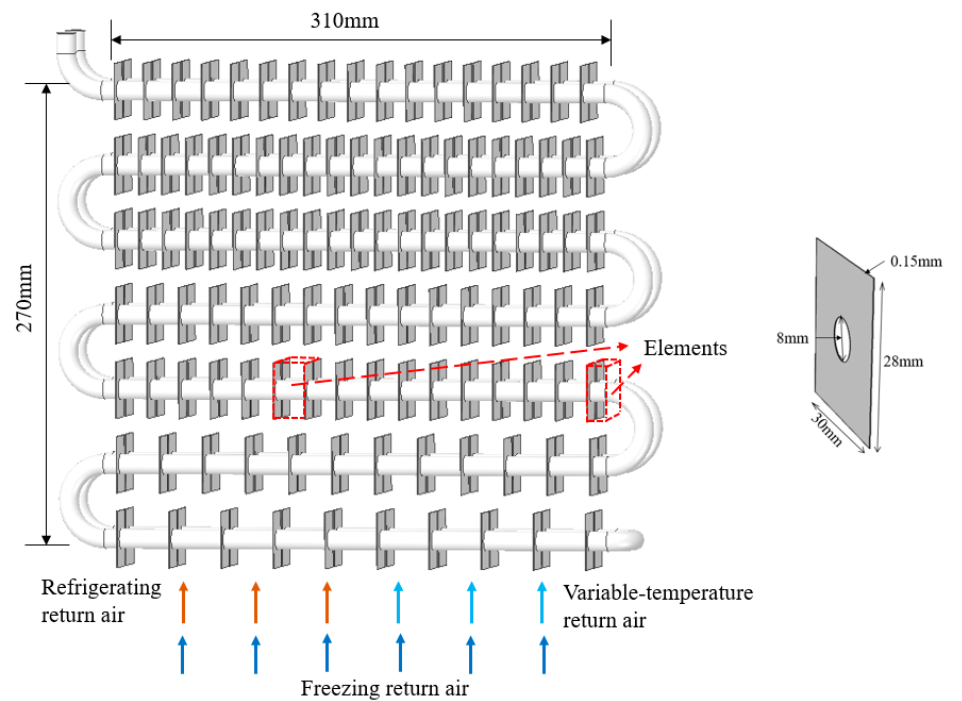
Figure 1. Schematic diagram of the evaporator.